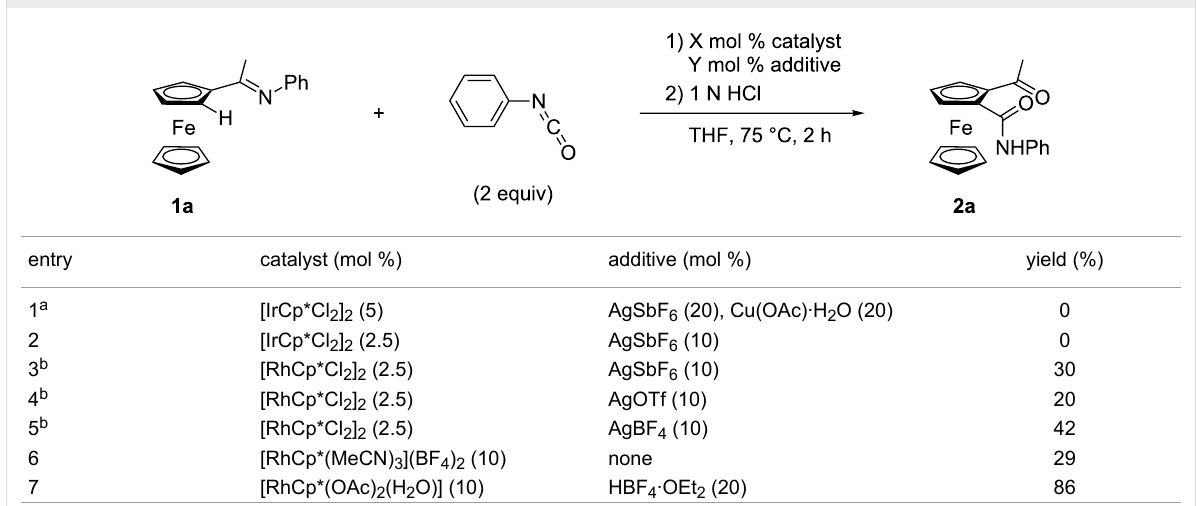
Table 1: Screening of